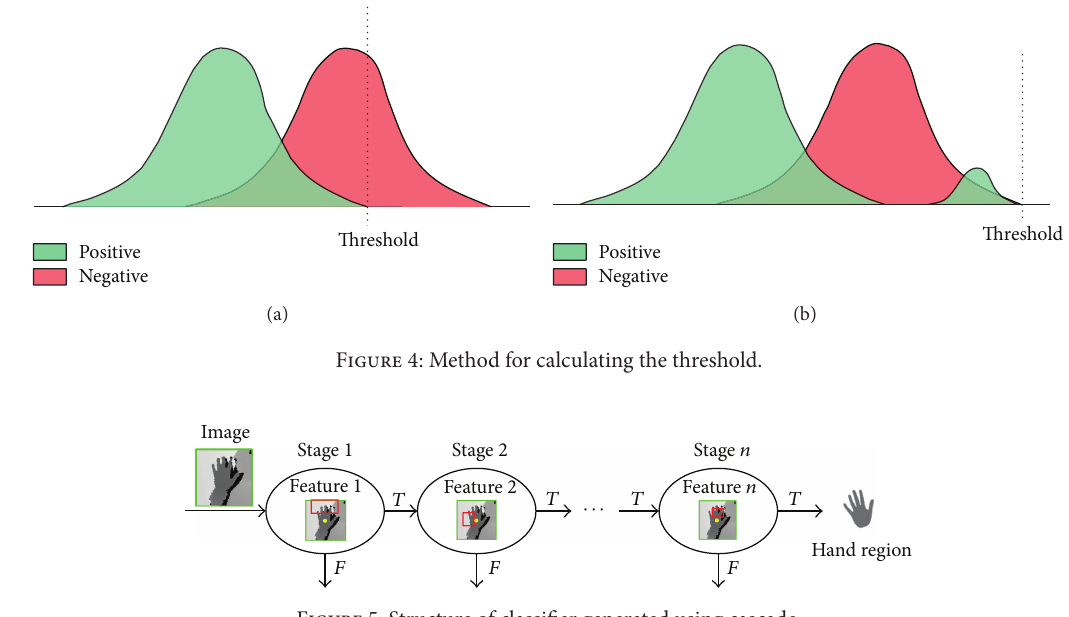
Figure 5: Structure of classifier generated using cascade.